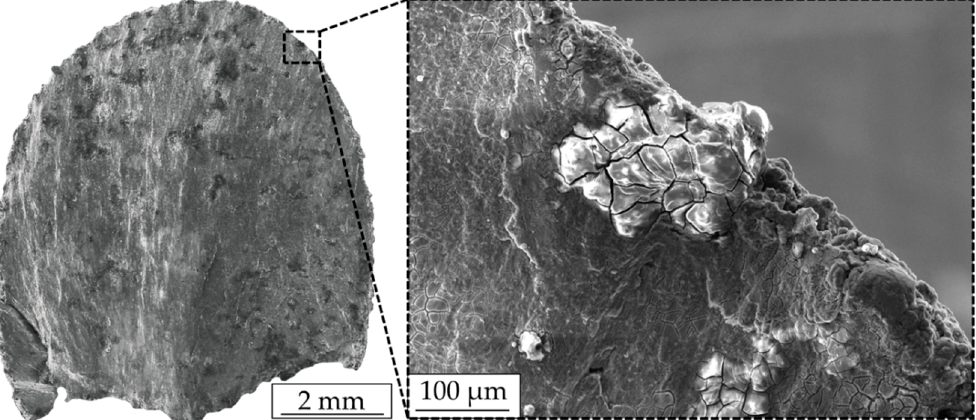
Figure 21. SEM images of an exemplary fractured surface of batch B Mg , tested in SBF at 37 °C.